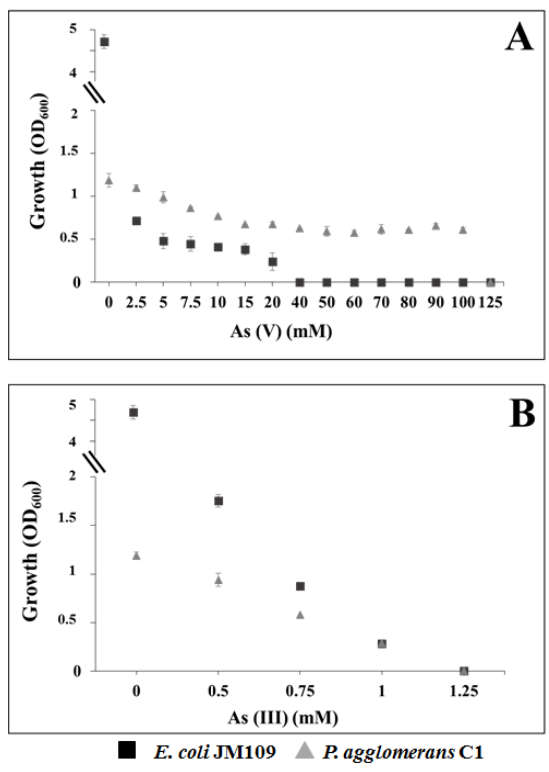
Figure 4. Growth of P. agglomerans C1 and E. coli K12 derivative JM109 in LB medium supplemented with increasing concentrations of arsenate, As(V) ( A ), and arsenite, As(III) ( B ).